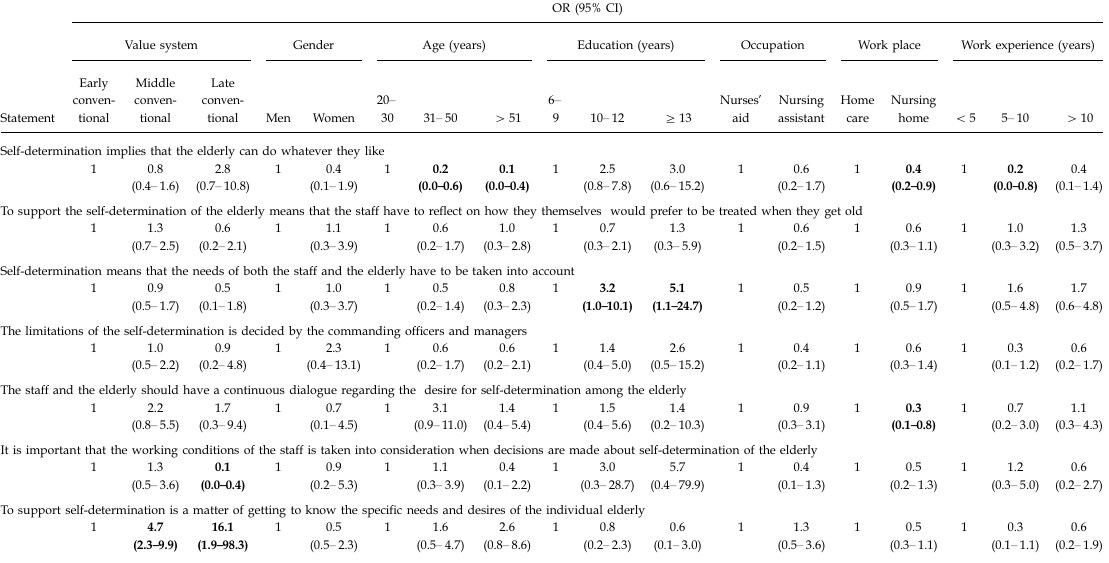
Table 5. Binary logistic regression models for predicting nursing assistants’ and nurses’ aides’ views on autonomy of the older